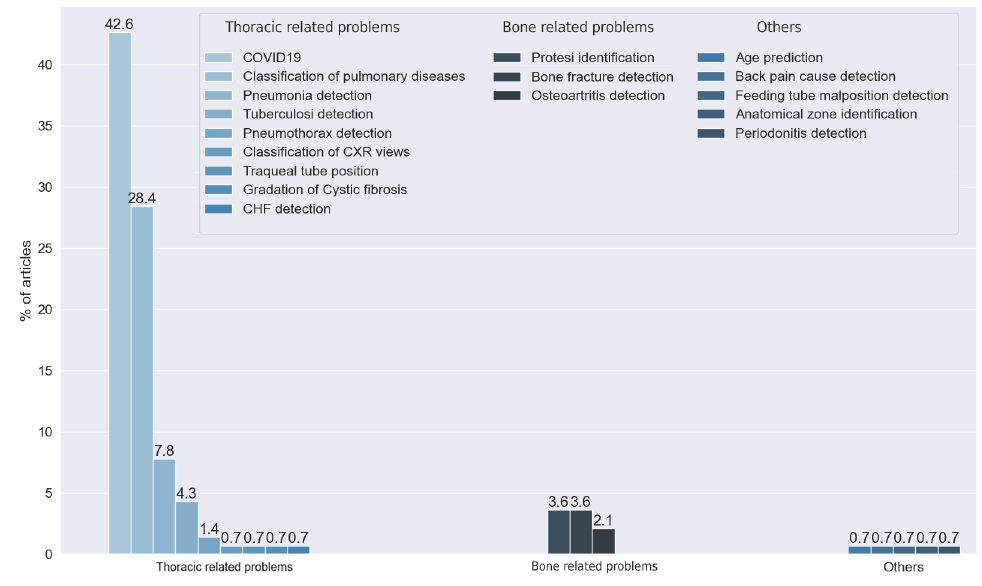
Figure 6. Answers to RQ1. Vertical axis indicates the percentage of articles for each